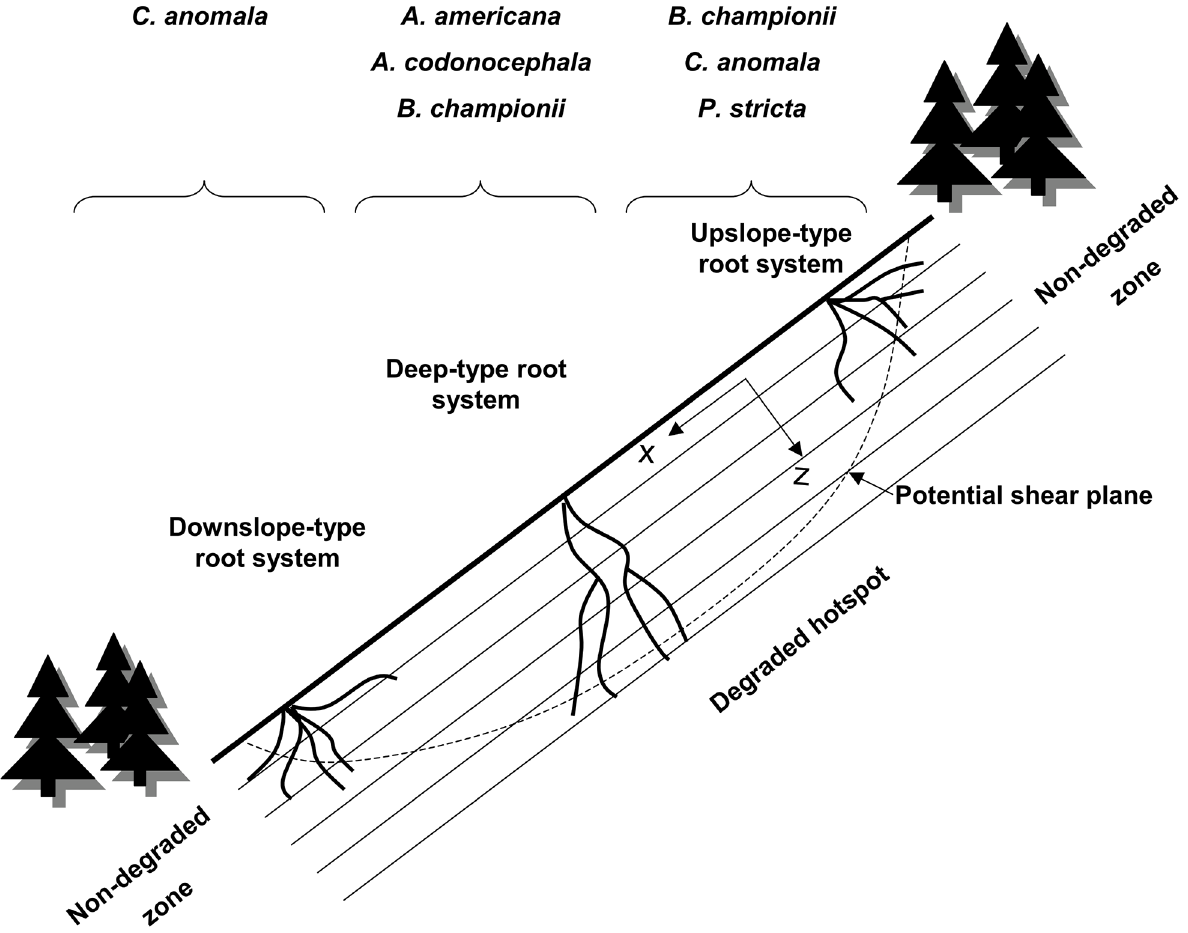
Figure 12. Best species depending on the location on the hotspot of instability. On degraded hotspots, the diversity of root systems will play an important role for slope stability. Roots growing upslope from the stem will have more chance to cross the potential shear plane if the plant grows at the top of the slope. Thus, root systems with desirable traits upslope of the stem will act more efficiently if they are located at the top of the slope, whereas the inverse is applicable for downslope roots. Root systems with desirable traits deeper in the soil will act more efficiently in the middle of the hotspot.